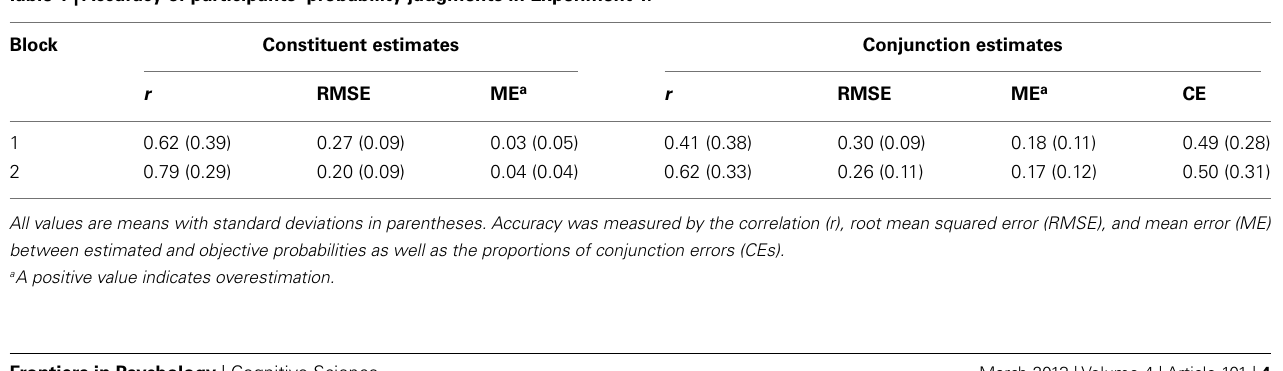
Table 1 |Accuracy of participants’ probability judgments in Experiment